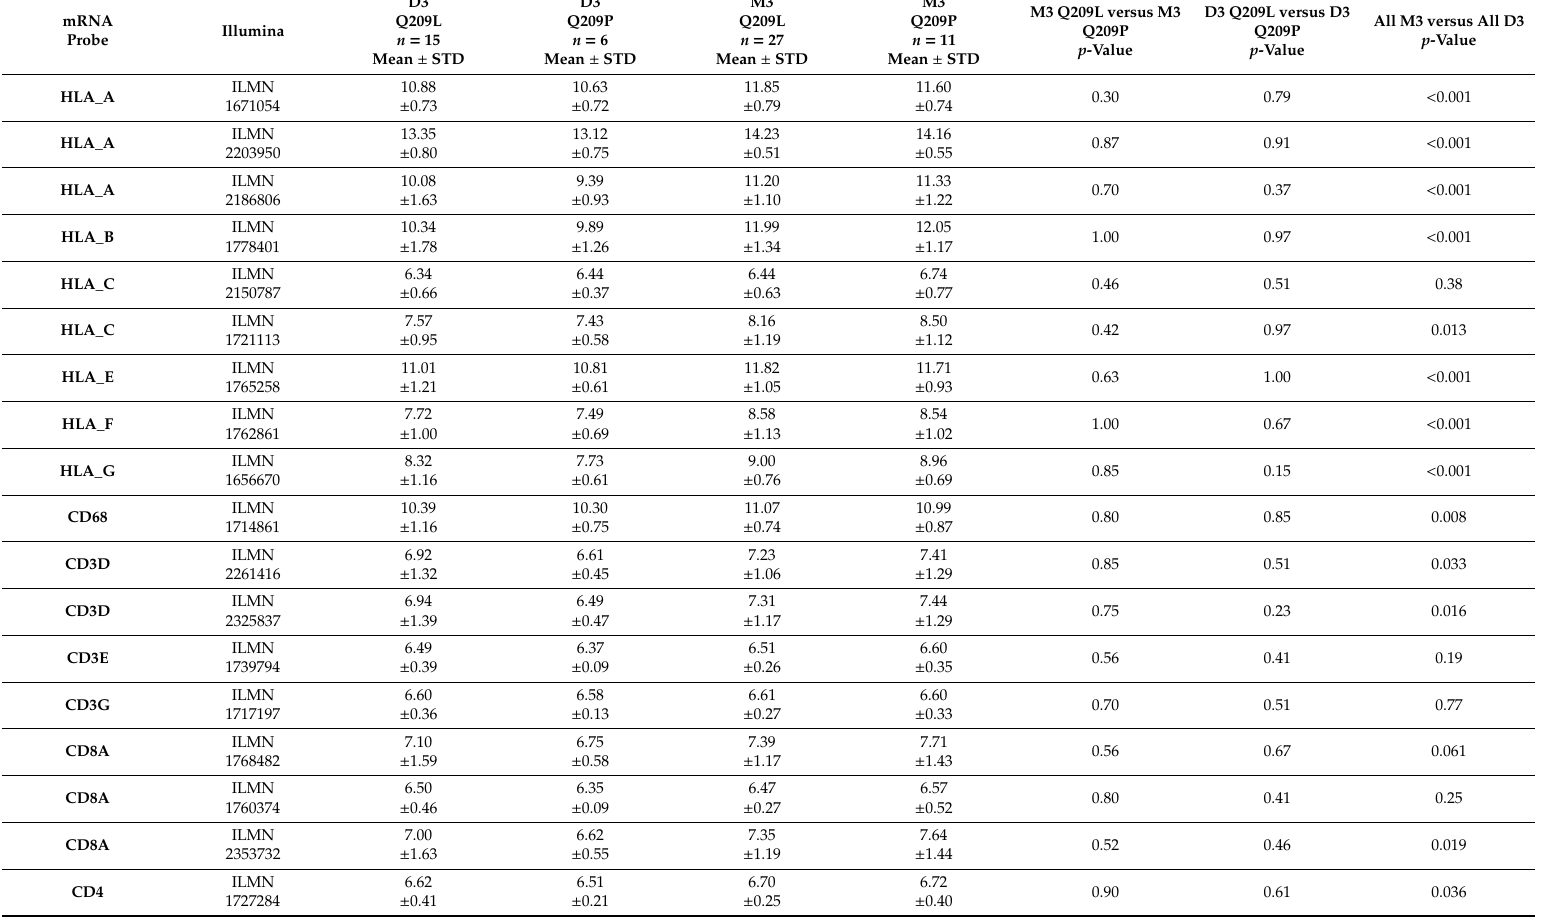
Table 4. Mean expression of mRNA expression of HLA Class I antigens and infiltrating immune cells in relation to Q209L or Q209P mutation on either GNAQ or GNA11 . p -values were calculated using the Wilcoxon-Rank sum test. STD = standard